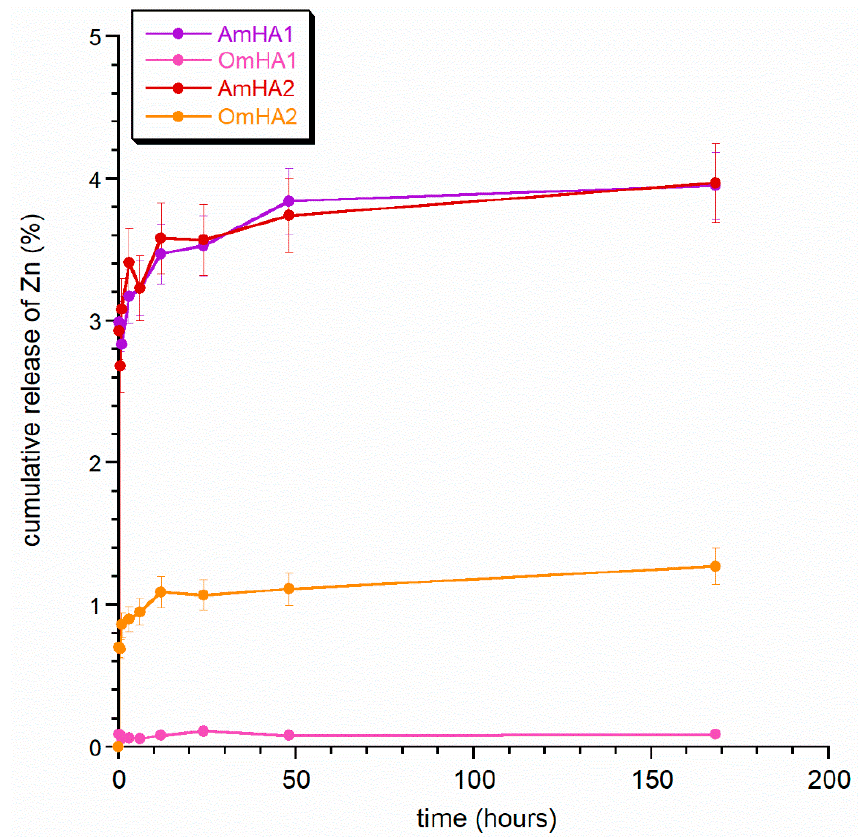
Figure 5. Release of zinc ions from the obtained composites.